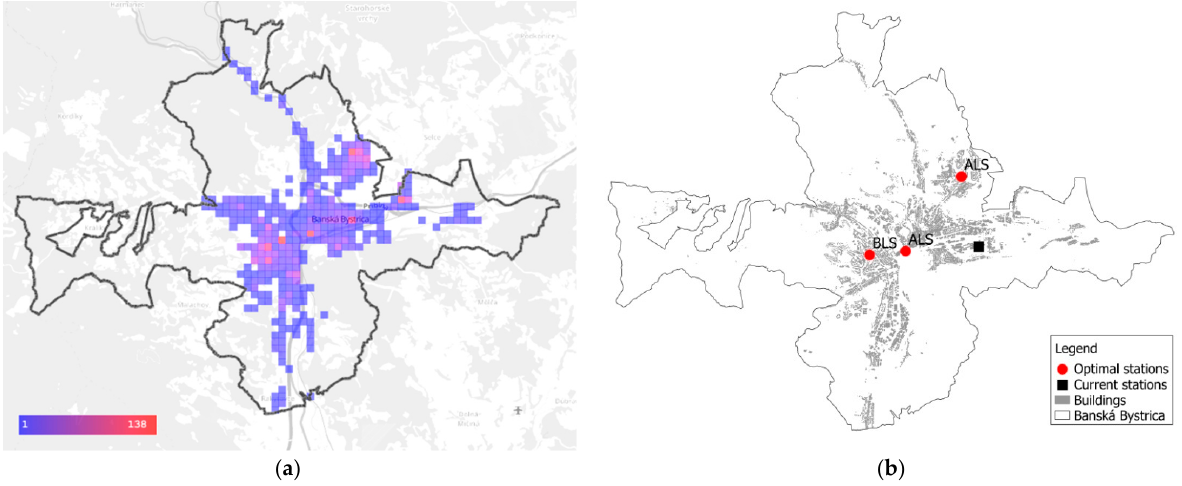
Figure 5. City of Banská Bystrica. ( a ) Distribution of demand; ( b ) Current and optimal locations of the stations; currently 4 stations are at the same address.